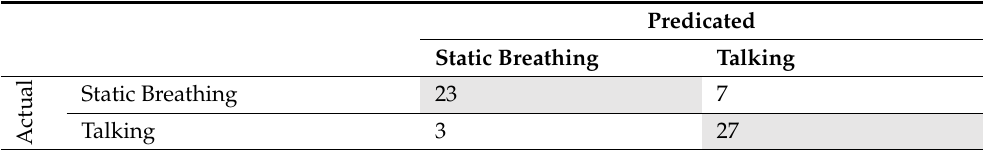
Table 5. Two-class confusion matrix for static breathing and talking. Rows represent actual class and columns represent predicted class.